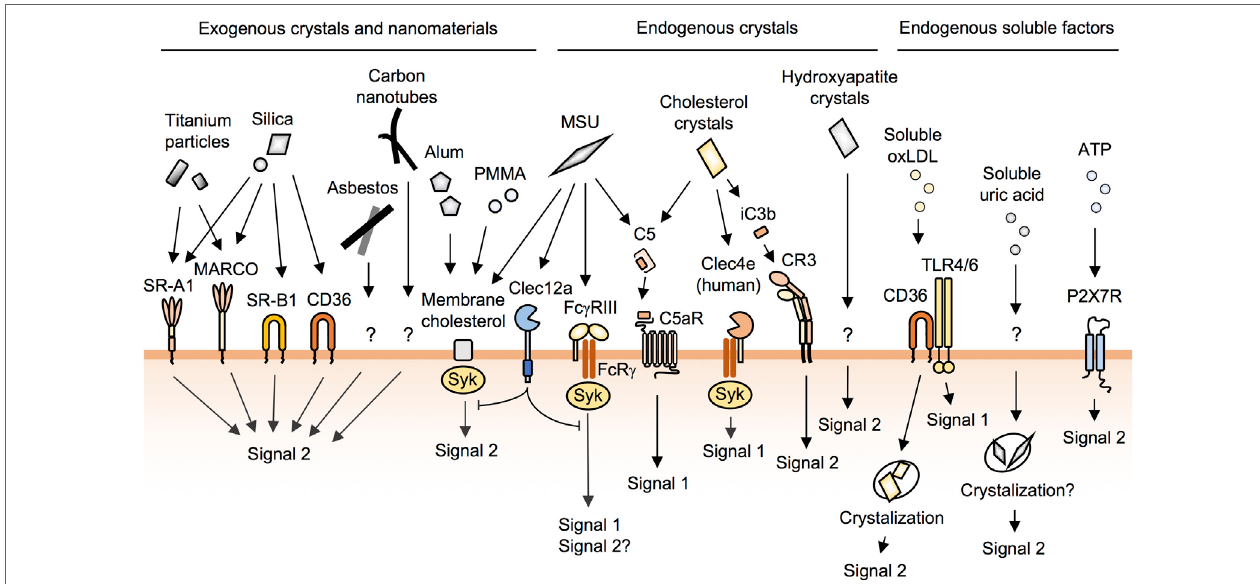
FigURe 2 | The recognition of crystals and nanoparticles on the macrophage surface. Macrophages recognize and internalize crystals and nanoparticles through cell-surface receptors and membrane cholesterol. Silica particles are recognized by SR-A1, MARCO, SR-B1, and CD36. Alum, poly(methyl methacrylate) (PMMA), and monosodium urate (MSU) crystals bind directly to membrane cholesterol to be internalized. MSU and cholesterol crystals activate complement pathways. Soluble oxidized low-density lipoprotein (oxLDL) is internalized by CD36 and then crystallized in phagosomes. P2X7R does not cause lysosomal damage. In addition to these, many unknown pathways of phagocytosis remain to be